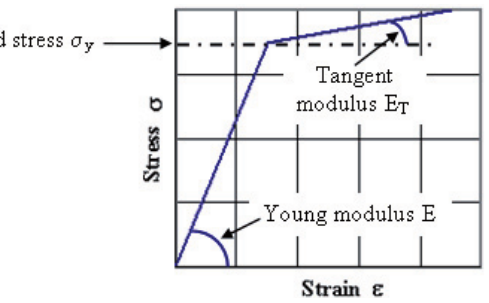
Fig. 2. Elastic-plastic behaviour